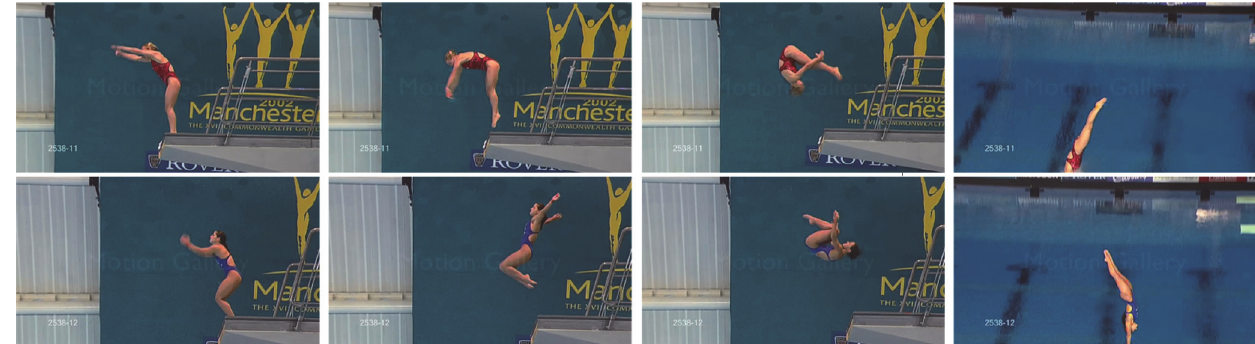
Figure 1: Two athletes perform the same action (diving water) in different